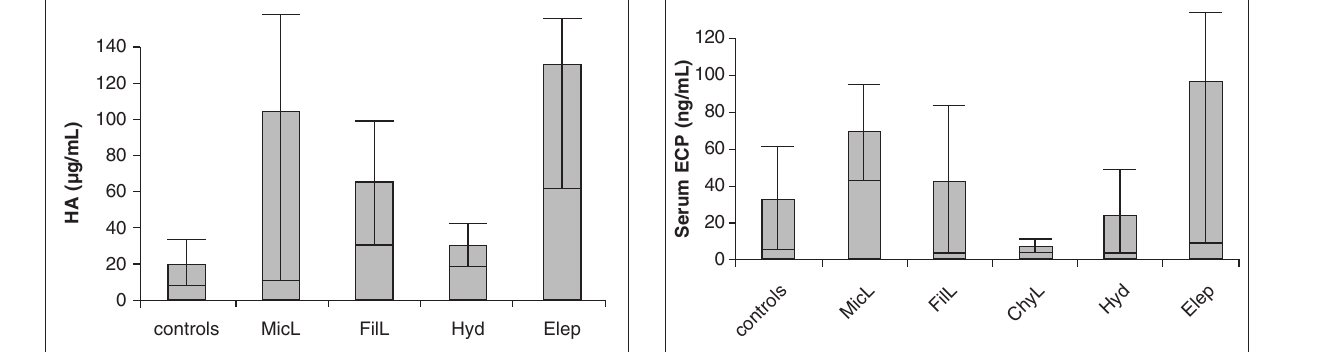
Fig. 3. – Serum levels of hyaluronan (HA), determined by radiometry, in patients with lymphatic filariasis according to their clinical status. FilL: filarial lymphangitis; ChyL: chyluria; Hyd: hydrocoele; EleP: ele- phantiasis, in comparison with controls and bacterial lymphangitis (MicL).